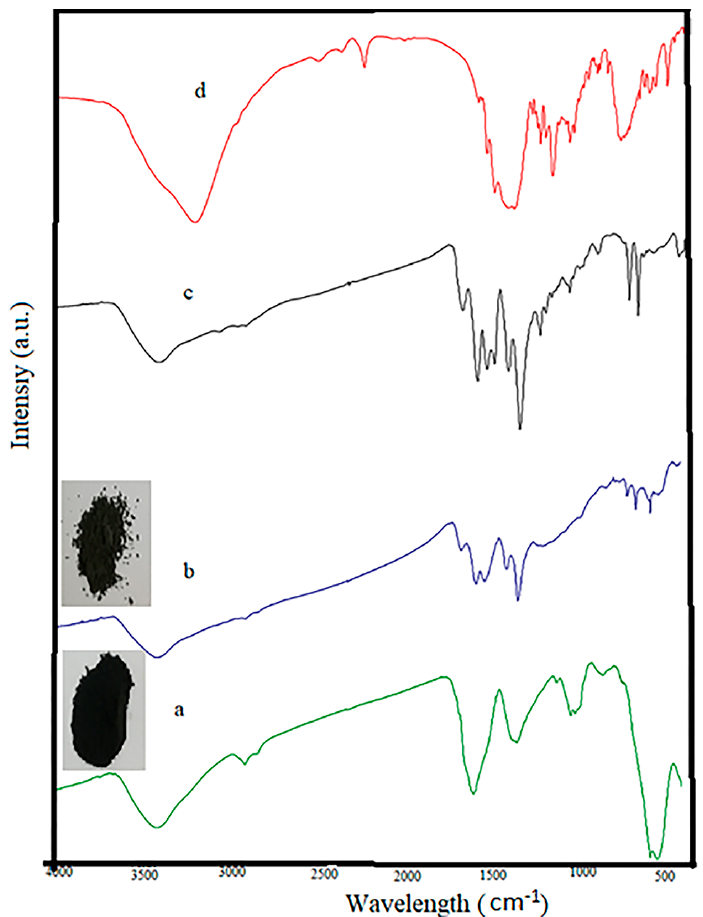
Figure 6. FT-IR spectra of ( a ) Fe 3 O 4 @AC, ( b ) MIL-100(Fe) @Fe 3 O 4 @AC, ( c ) Rhodamine B (RhB) loaded on MIL-100(Fe) @Fe 3 O 4 @AC and ( d ) RhB.